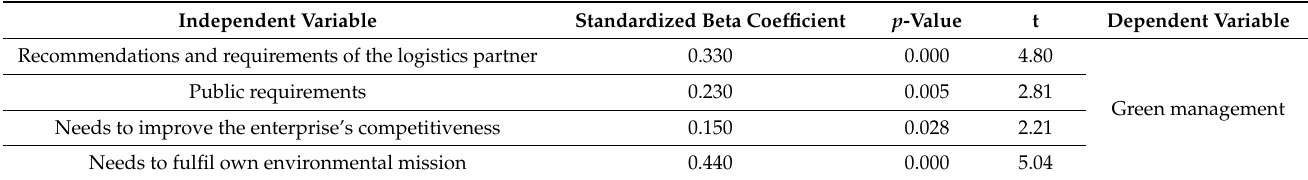
Table 6. Factors influencing the application of green